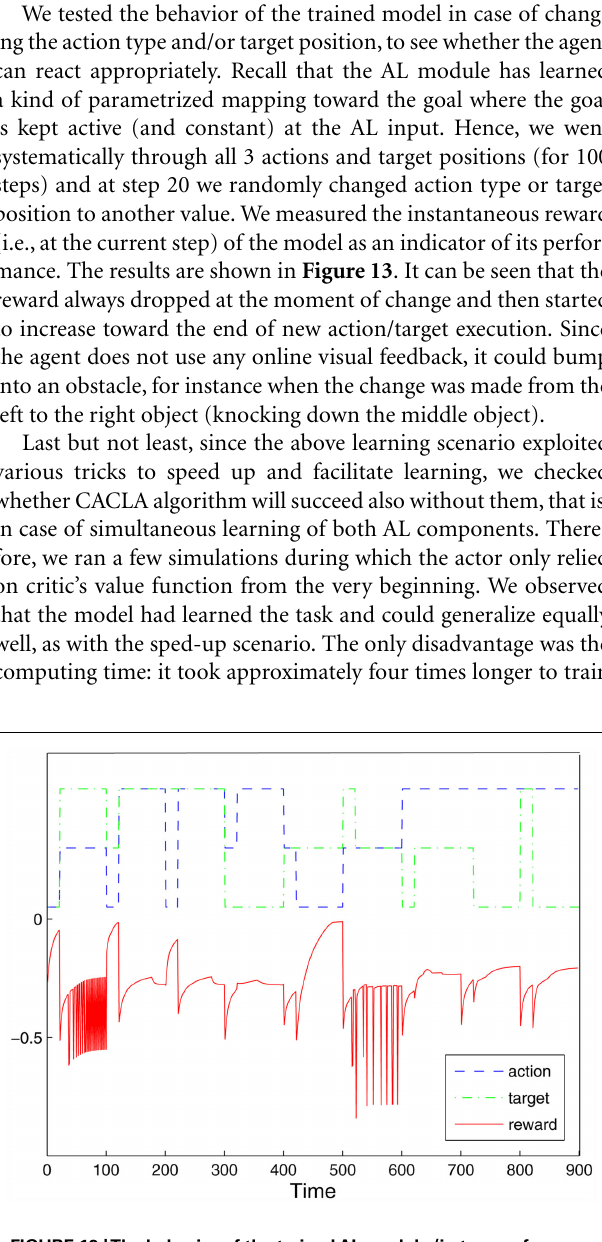
FIGURE 13 |The behavior of the trainedAL module (in terms of reward) in response to the sudden change of the action type or the target position. The growing value of the instantaneous reward, immediately after the change, serves as an indicator that the agent successfully responses to the new goal.